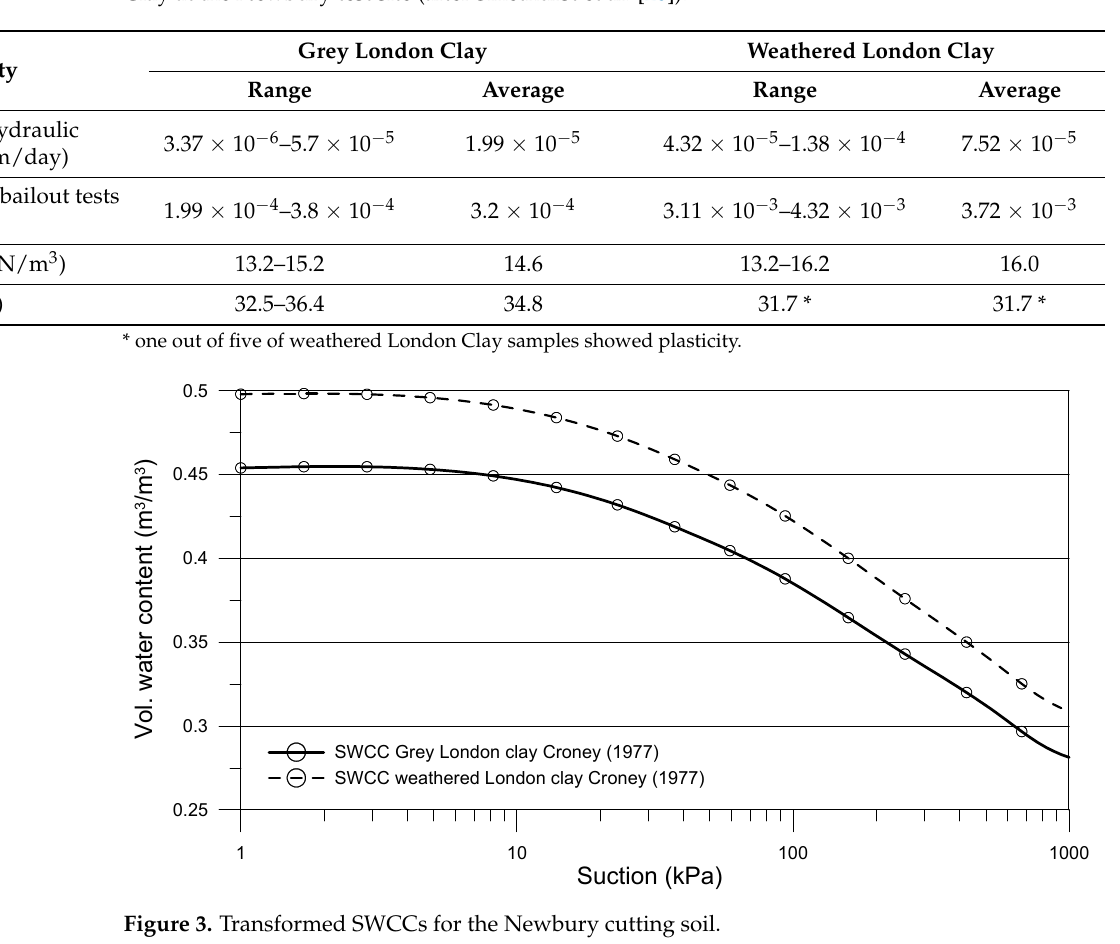
Table 1. Hydraulic conductivity, unit weight and plasticity index of grey and weathered London Clay at the Newbury test site (after Smethurst et al. [20]).